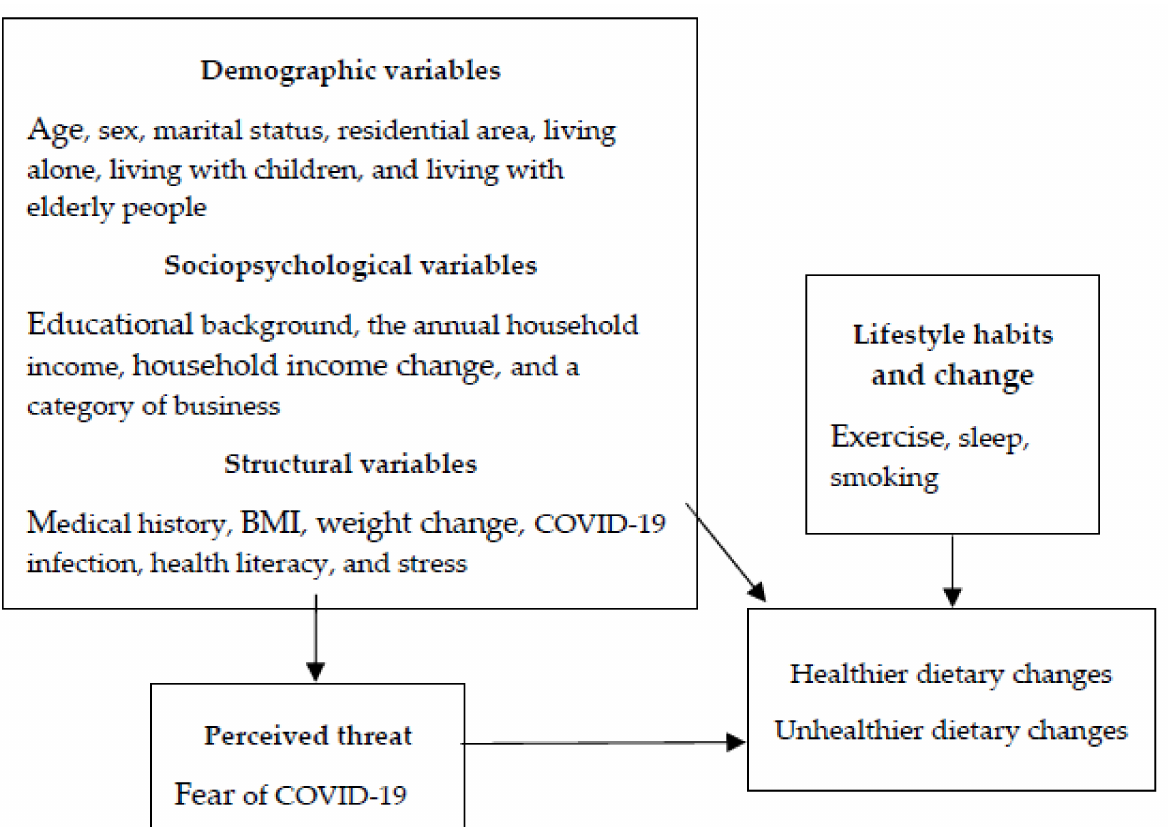
Figure 1. Hypothesis of this